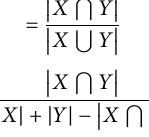
FIGURE 5 Typical spinal ultrasound